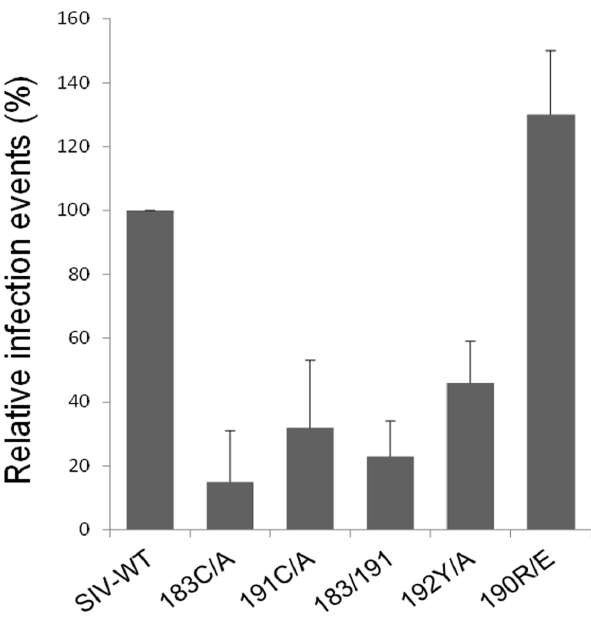
Figure 2. Infectivity of the twin-cysteine mutants and other gp120 V2 region mutants of SIVmac239. Viruses pseudotyped with the wild-type (wt) and mutant SIVmac239 Envs were made with a GFP-expressing vector and used to infect TZM-bl target cells. The infectivity was evaluated by measuring the fluorescence intensity of GFP by flow